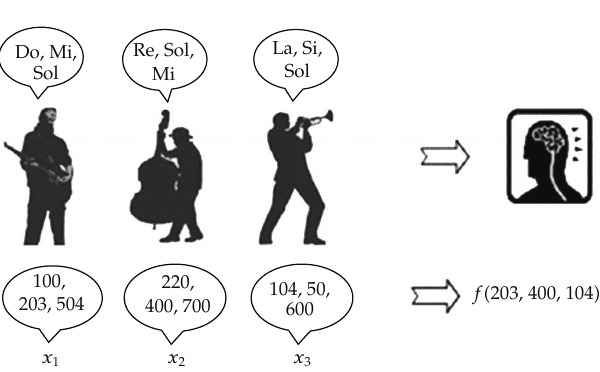
Figure 1: Analogy between music improvisation and engineering